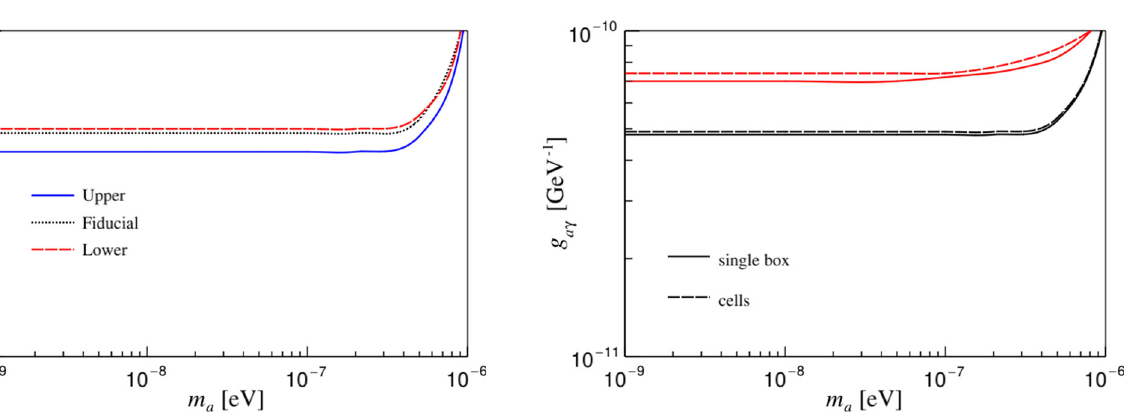
Fig. 11 Variation in the bound on g a γ in dependence of the initial fluxes described in Table 1: Upper (blue continuous curve), Fiducial (black dotted curve) and Lower (red dashed curve)